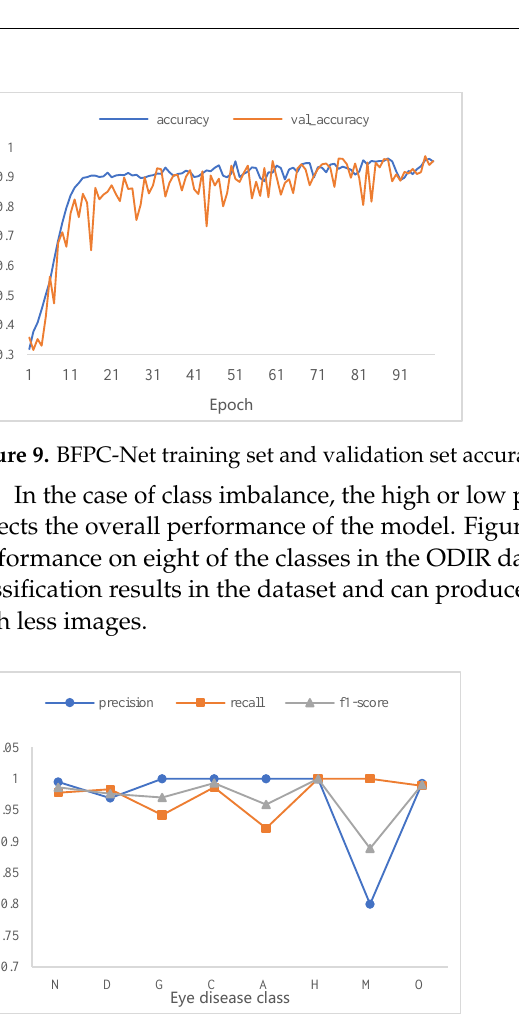
Figure 8. BFPC-Net training set and validation set losses.